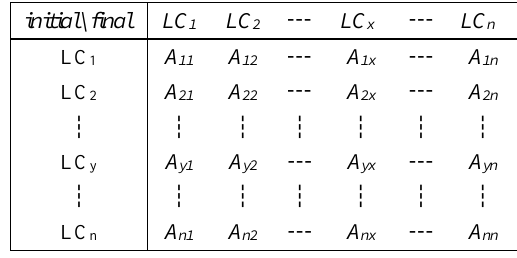
Table2. Land use transfer